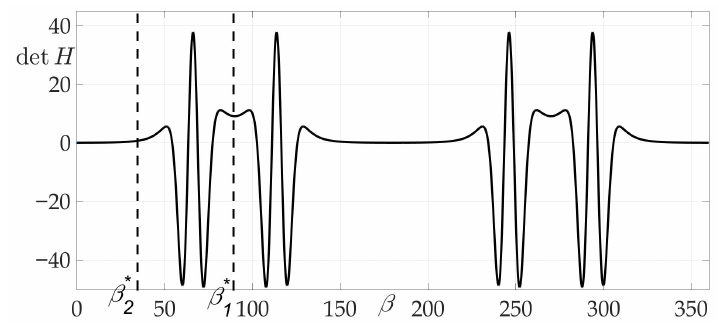
Figure 16. Dependence of Hessian det H from β .